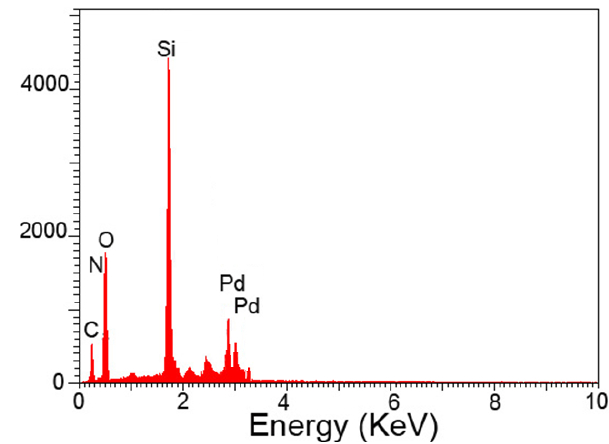
Fig. 6. EDX spectrum of Pd@modified SBA-15 Figure 6. EDX spectrum of Pd@modified SBA‐15